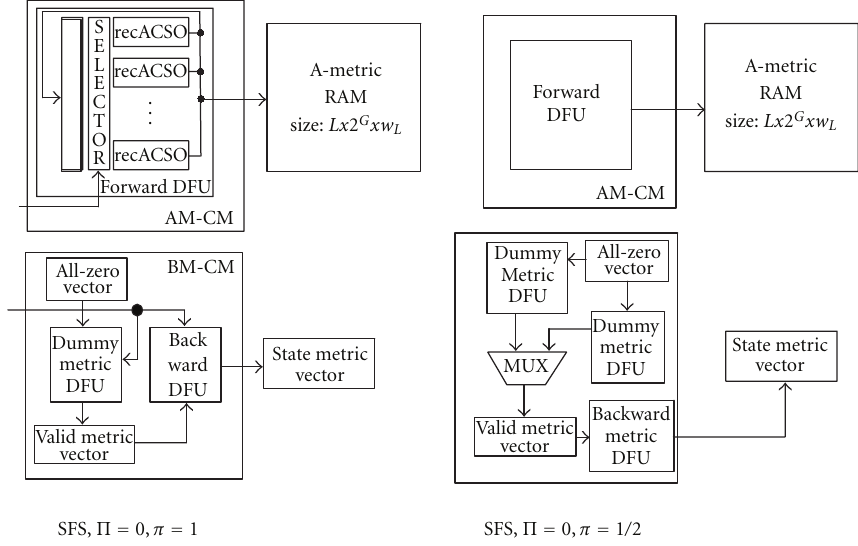
Figure 8: State metric calculation modules for single-flow structures.